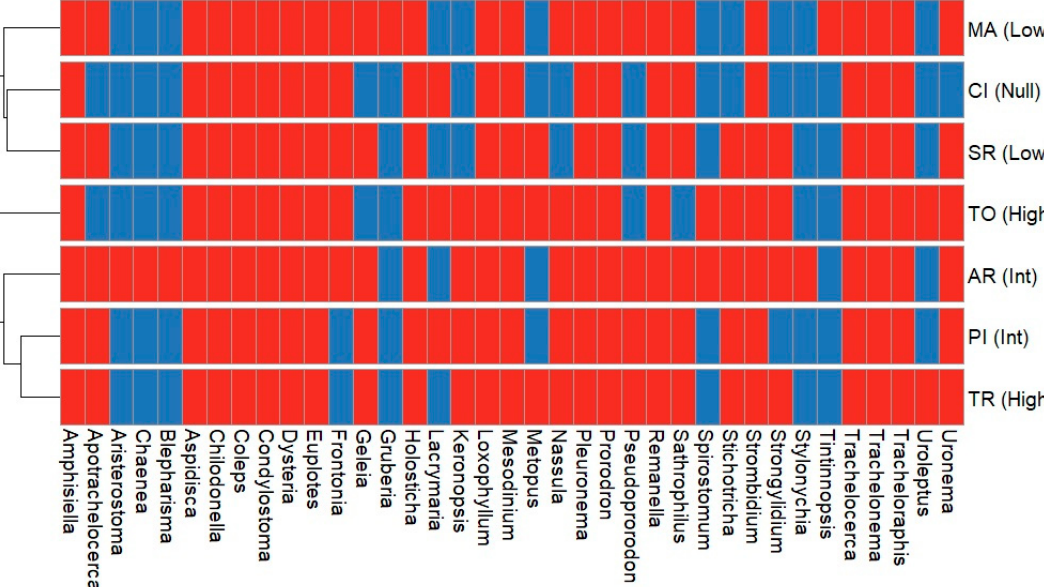
Figure 4. Clustered heatmap based on data collected from seven northern Rio Grande do Sul state (Brazil) sites during the study period (June 2016 to July 2017). Clustering criterion was complete linkage, based on Euclidean distances between sites. Colors represent presence (blue) or absence (red) of species in each site (AR: Arroio do Sal, CI: Cidreira, MA: Magistério, PI: Pinhal, SR: Santa Rita, TO: Torres, TR: Tramandaí).